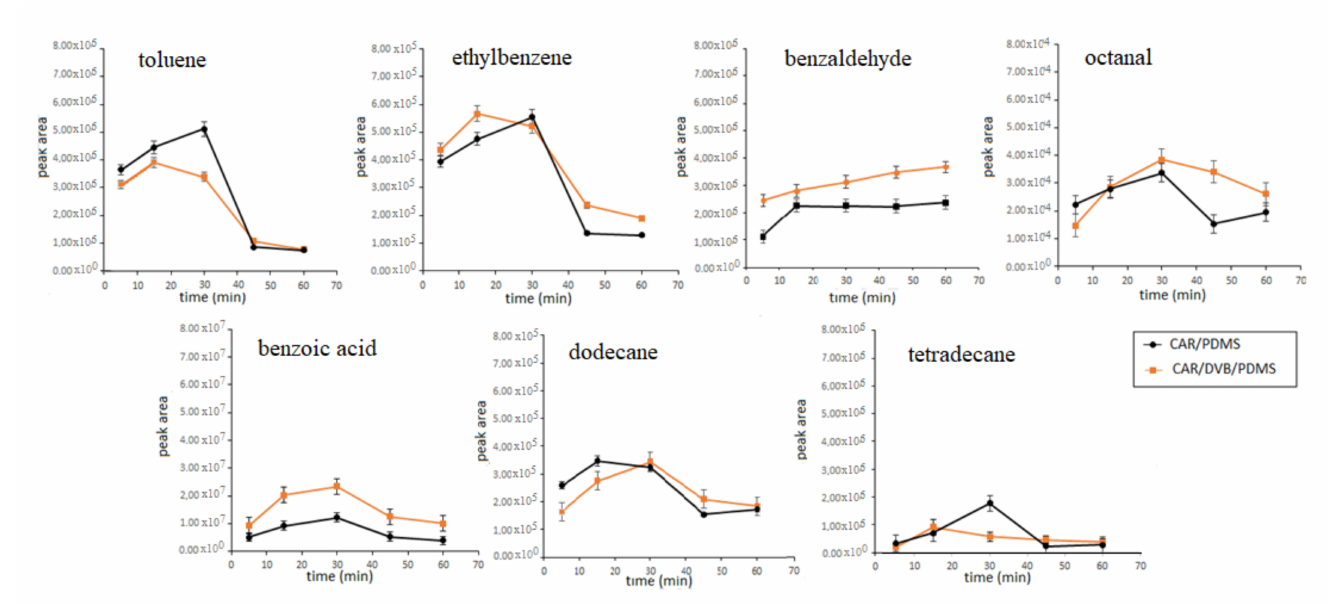
Figure 2. HS extraction time profiles obtained with both selected fibers at 37 ◦ C.